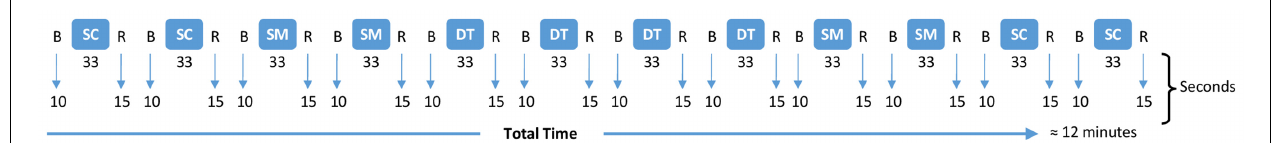
FIGURE 2 | Experimental protocol for a run. B = baseline (fNIRS quiet standing); R = rest; SC = single cognitive (SRT, GNG, NBK or DNS in a randomized run order while standing); SM = single motor (usual walking); DT = dual-task (cognitive task and walking).